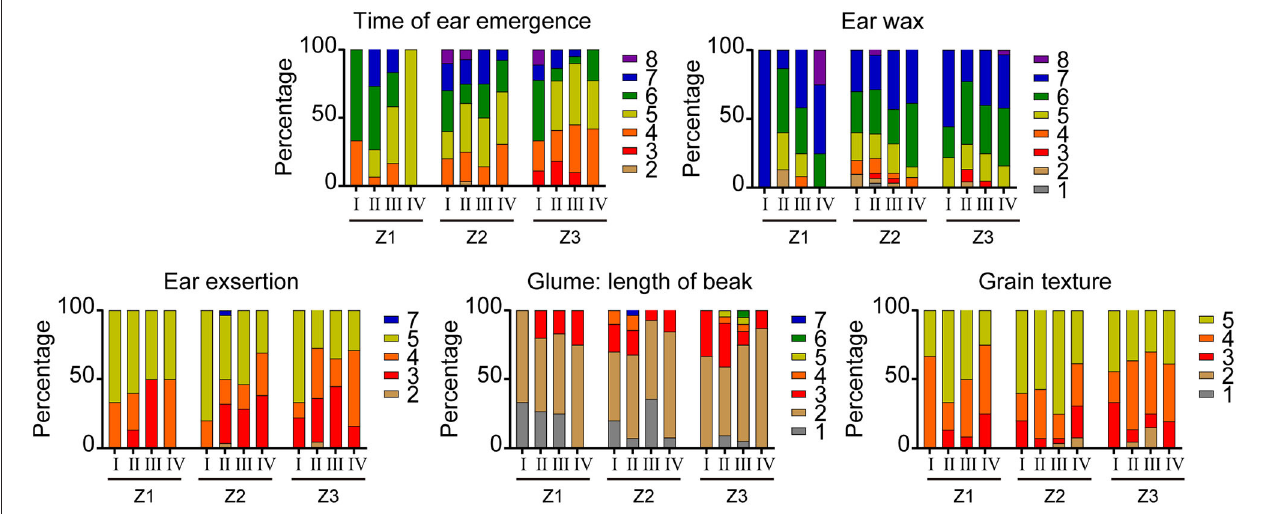
FIGURE 4 | Changes in five visually assessed characteristics of wheat varieties with the third artificial selection trend. The legends have the same meaning as